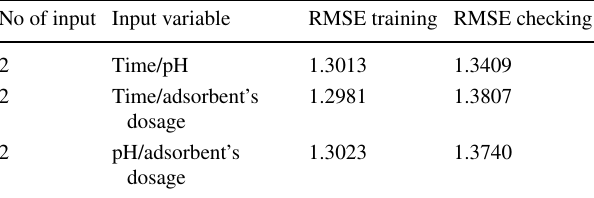
Table 4 Two-input variable ANFIS (exhaustive search) for iron (II) removal